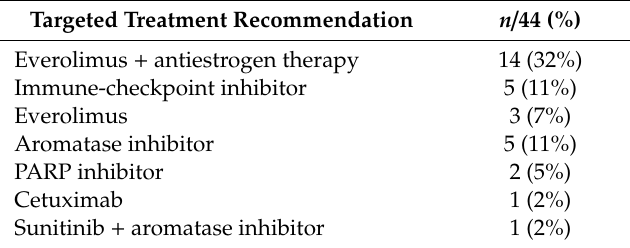
Table 2. Recommended targeted